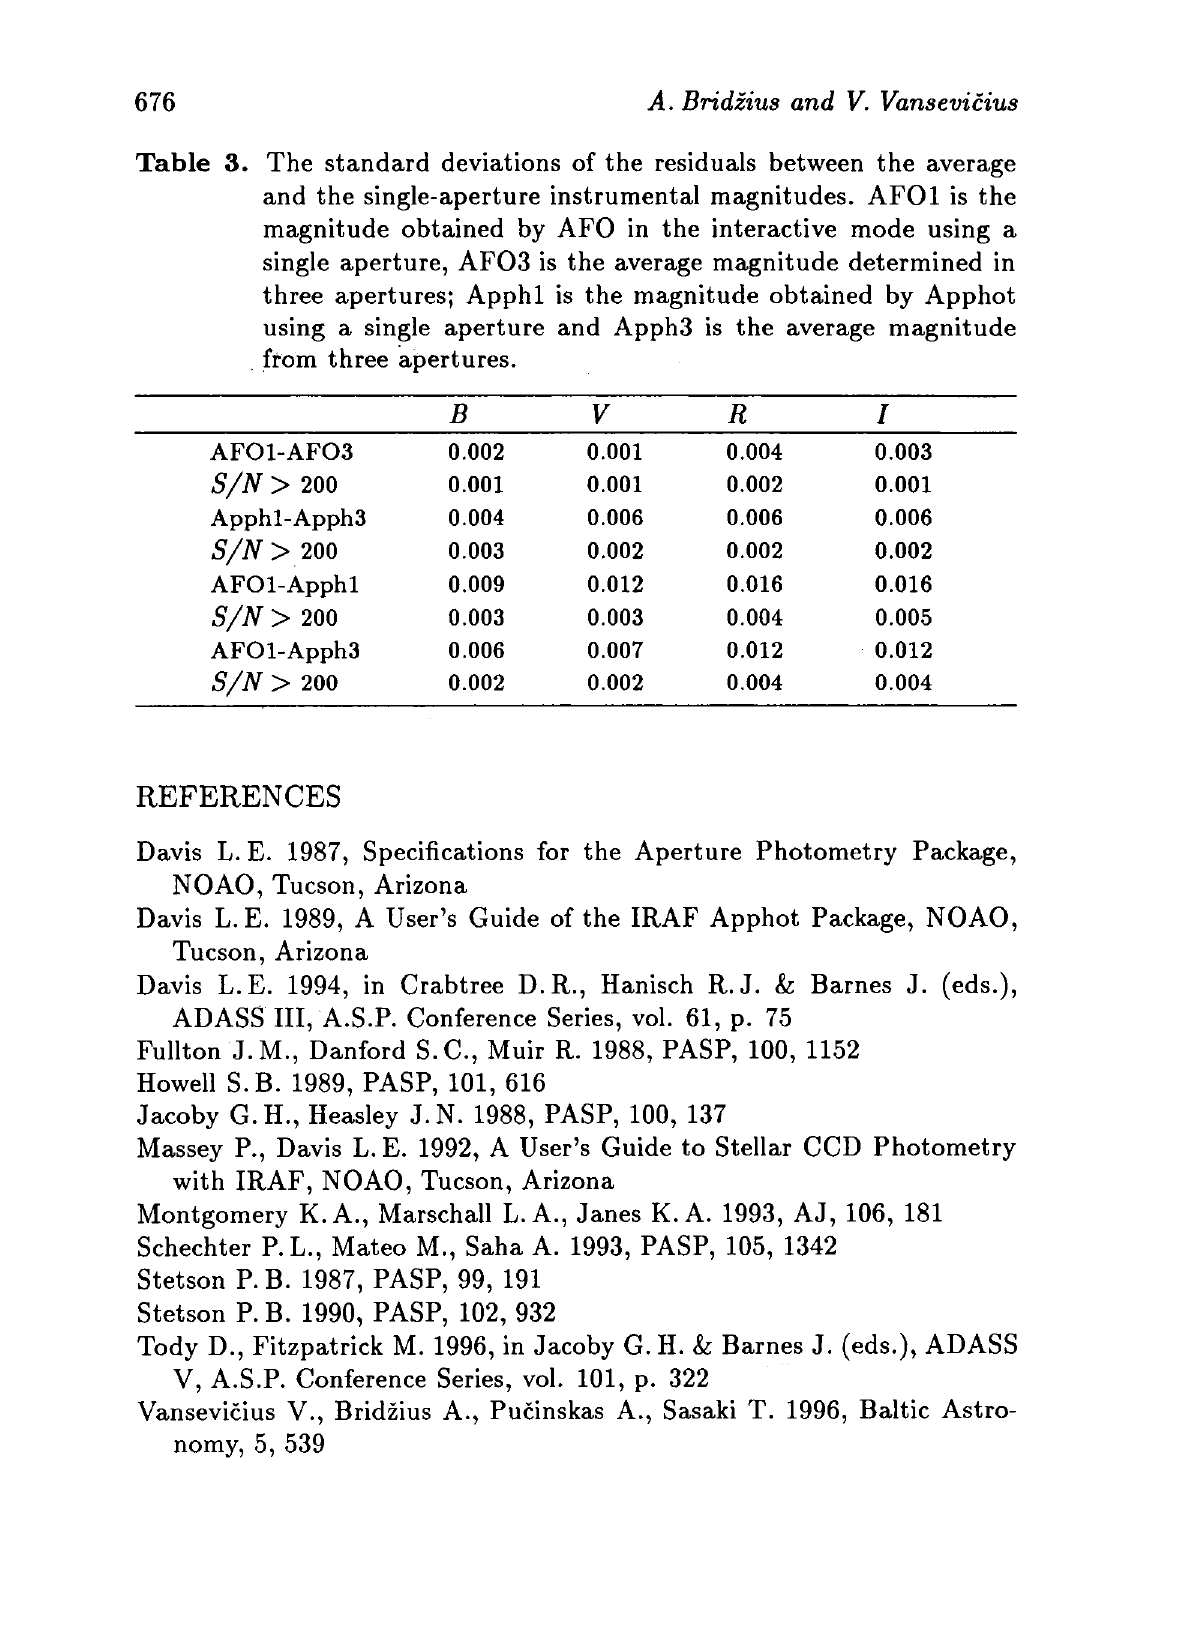
Table 3. The standard deviations of the residuals between the average and the single-aperture instrumental magnitudes. AF01 is the magnitude obtained by AFO in the interactive mode using a single aperture, AF03 is the average magnitude determined in three apertures; Apphl is the magnitude obtained by Apphot using a single aperture and Apph3 is the average magnitude from three apertures. B V R I AF01-AF03 0.002 0.001 0.004 0.003 S/N > 200 0.001 0.001 0.002 0.001 Apphl-Apph3 0.004 0.006 0.006 0.006 S/N > 200 0.003 0.002 0.002 0.002 AFOl-Apphl 0.009 0.012 0.016 0.016 S/N > 200 0.003 0.003 0.004 0.005 AF01-Apph3 0.006 0.007 0.012 0.012 S/N > 200 0.002 0.002 0.004